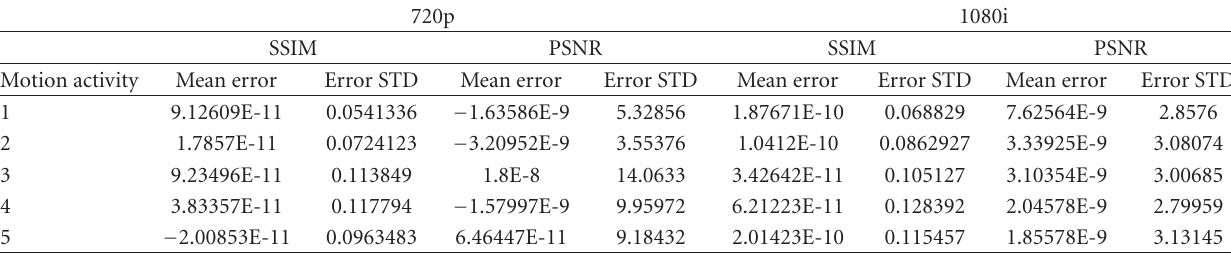
Table 6: Mean errors and standard deviations of model for Qm B2